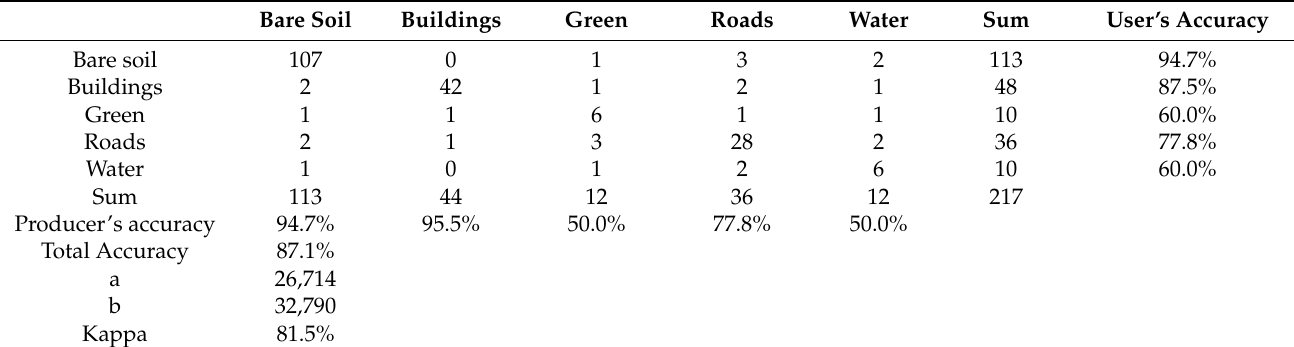
Figure 4. Land-use map of the study area. Table 1. Classification accuracy of land-use map.